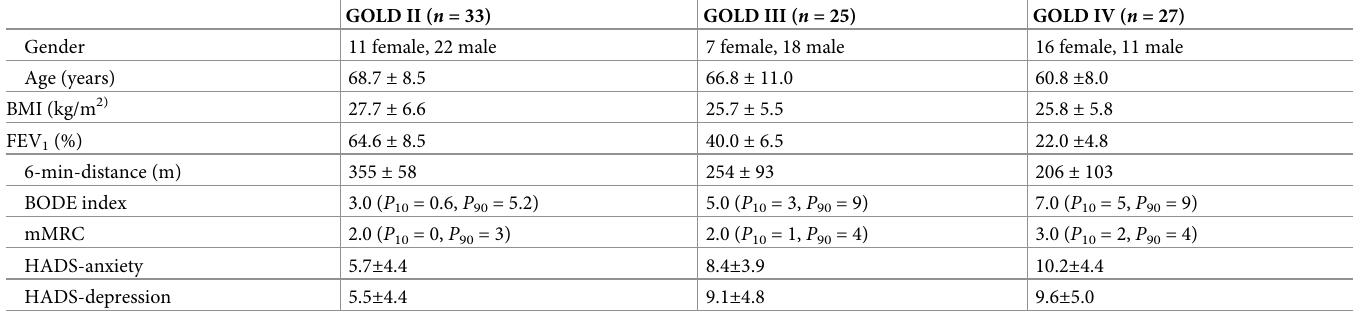
Table 1. Means, standard deviations or median and percentile of the demographic variables, somatic, pulmonary function and HADS variables of the 85 hospital- ized COPD patients without major comorbidities separated for the three GOLD stages.